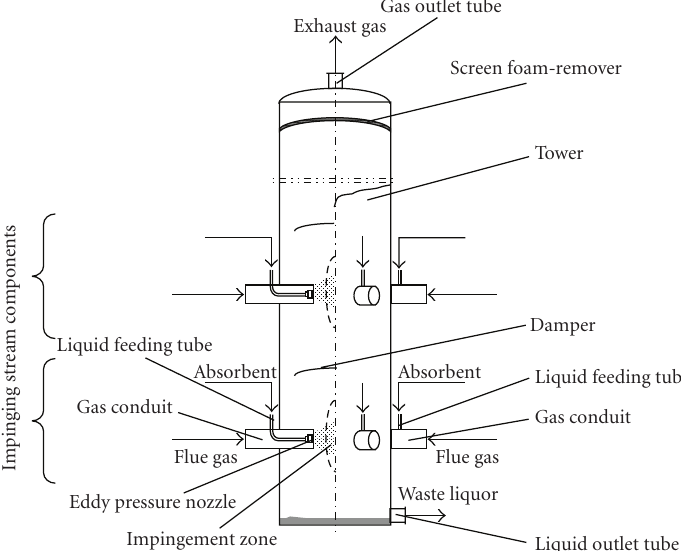
Figure 5: Brief view of HFISGLR 1-tower; 2-screen foam-remover; 3-gas outlet tube; 4-liquid outlet tube; 5-gas conduit; 6-eddy pressure nozzle; 7-liquid feeding tube; 8-damper I, II ... : impinging stream